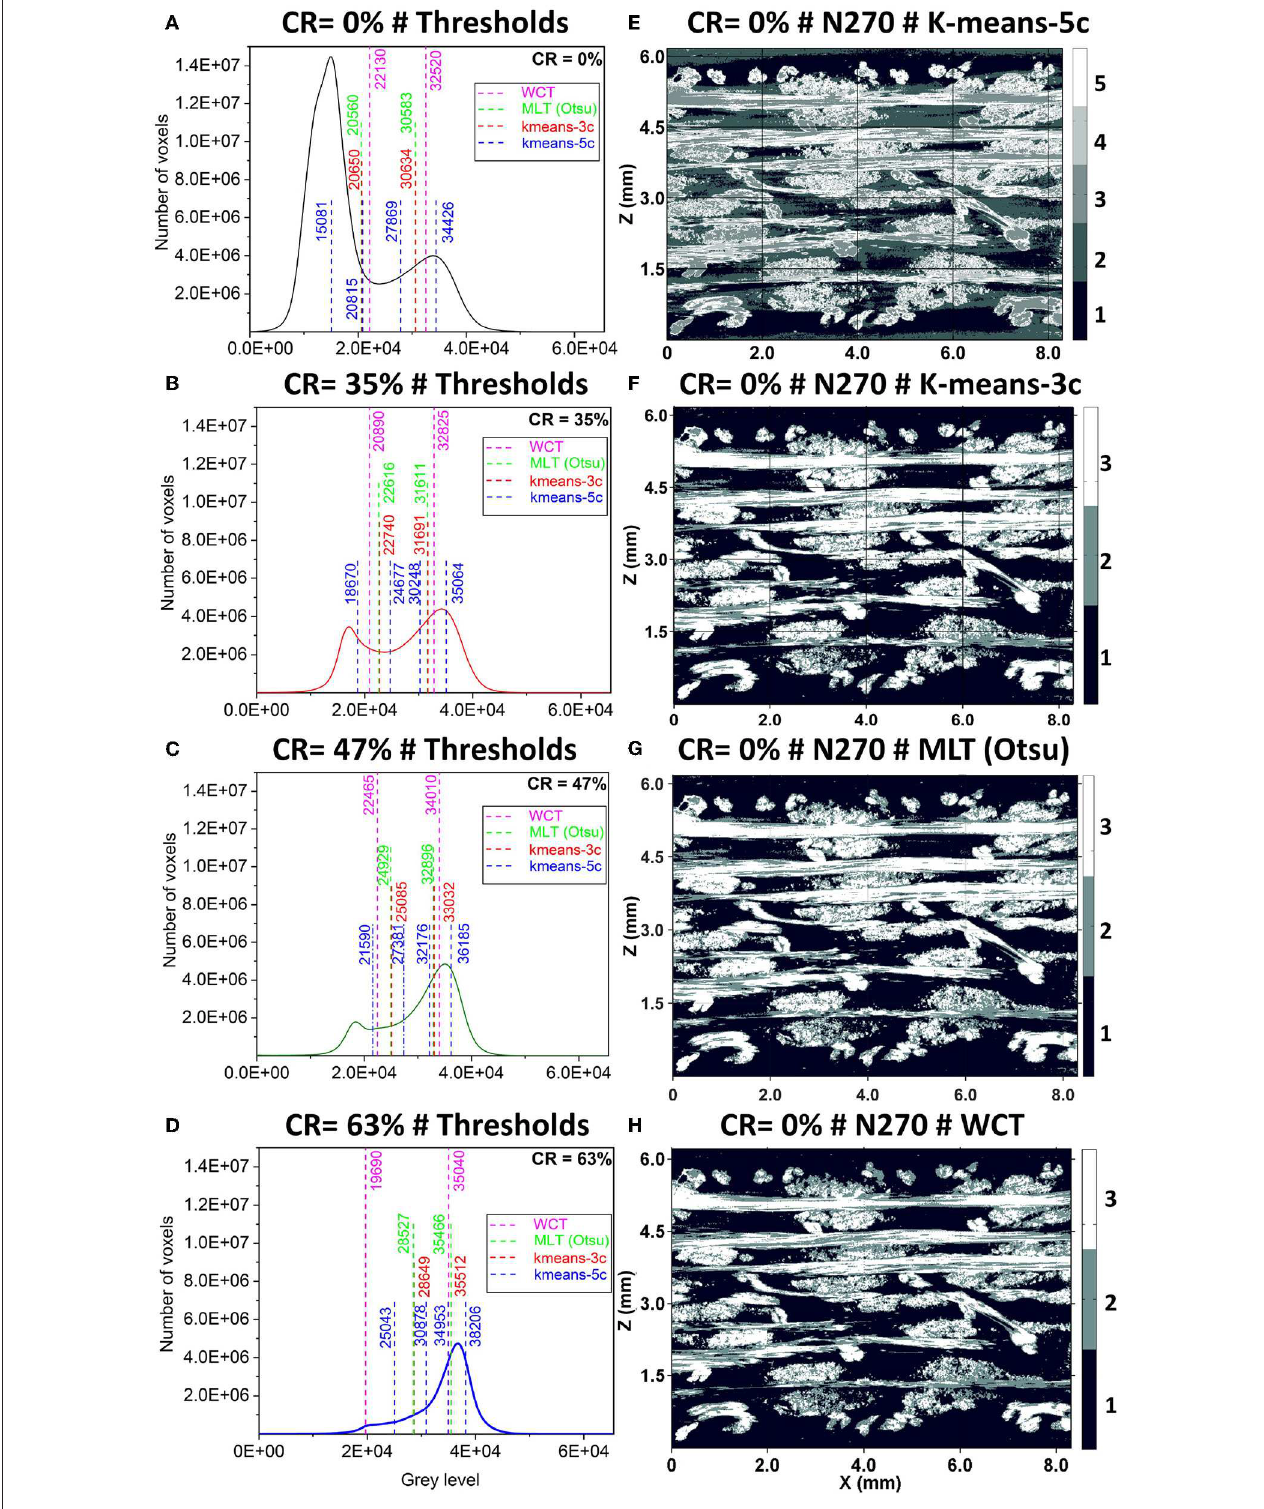
FIGURE 6 | (A–D) Gray level histogram of the segmented 3D µ CT images with the thresholds evaluated according to the WCT, k-means-3c, k-means-5c, and MLT methods. (E–H) Segmentation out-put of the same 2D slice from the non-consolidated sample (CR = 0%) according to the four methods. Numbers correspond to the obtained clusters sorted in an increasing order of gray